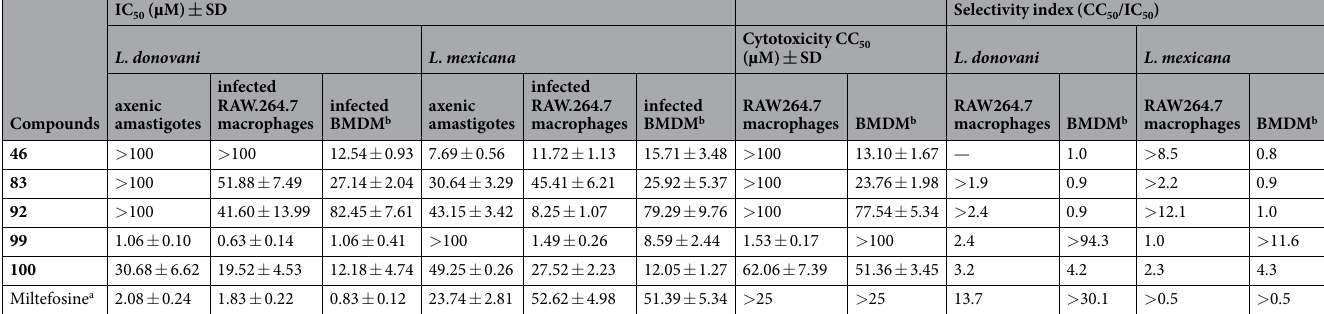
Table 1. Antileishmanial and cytotoxic activities of compounds 46, 83, 92, 99 and 100. The results expressed correspond to the mean of three independent experiments ( ± SD). (a) Miltefosine: reference compound. (b) BMDM: Bone Marrow Derived